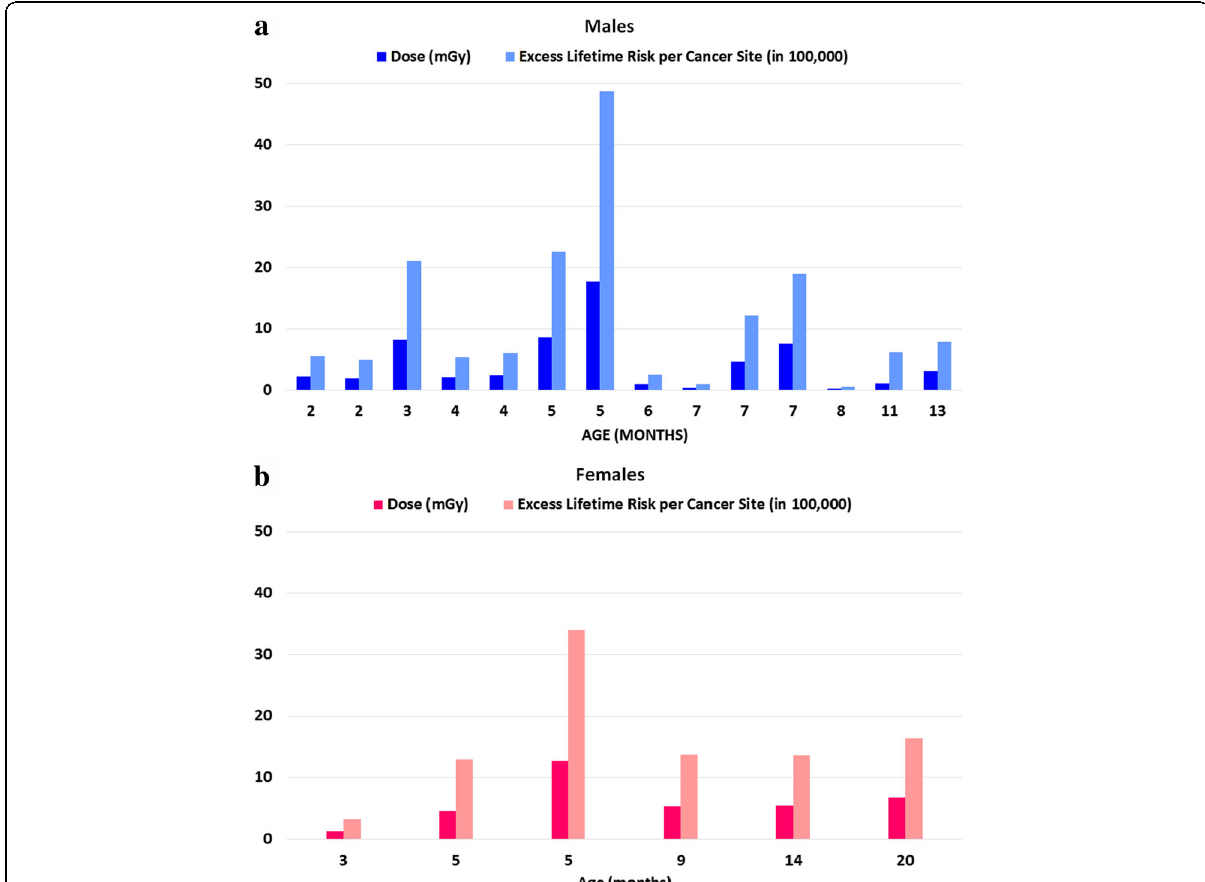
Fig. 5 Absorbed doses to the bladder (mGy) and excess lifetime risk (chances in 100,000 persons) as a function of age (months). a Male group with 14 patients aged between 2 and 13 months. b Female group with 6 patients aged between 3 and 20